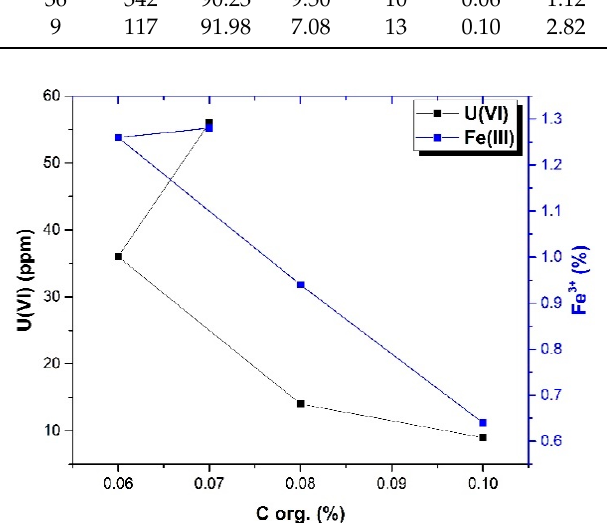
Figure 3. Trend of U(VI) and Fe(III) with organic carbon (C org.) in uranium ore. Table 6. Composition of pitchblende (%) analyzed by EPMA.